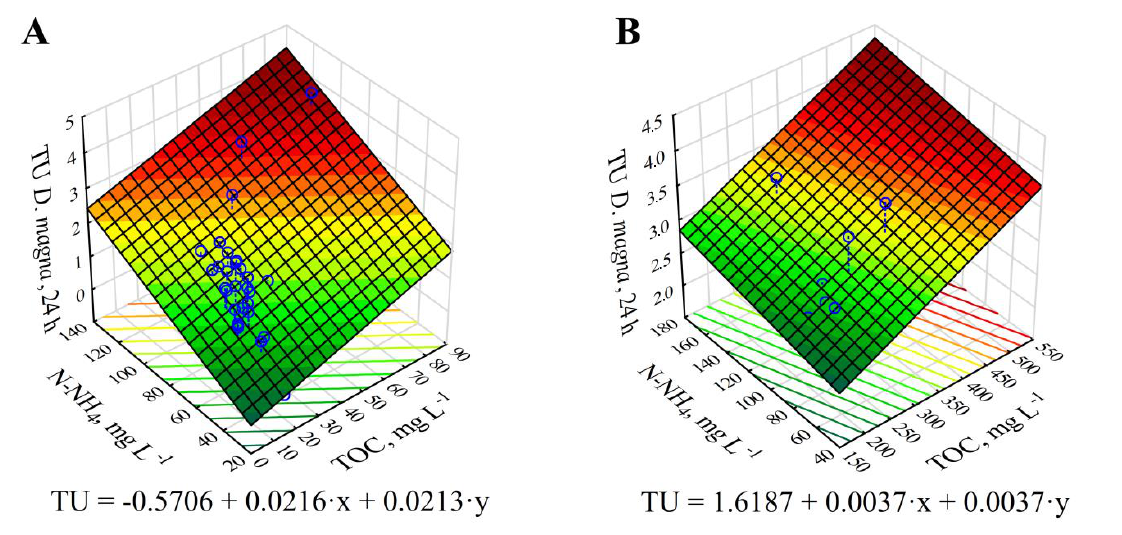
Figure A4. Correlations analysis between toxicity to D. magna and the chemical parameters of wastewater. ( A ) Wastewater with TOC < 100 mg L − 1 ; ( B ) Wastewater with TOC ≥ 100 mg L − 1 ; where x is the TOC concentration (mg L − 1 ) and y is the N-NH 4 concentration (mg L − 1 ). Table A7. Equations obtained from correlation analysis. Test Organisms